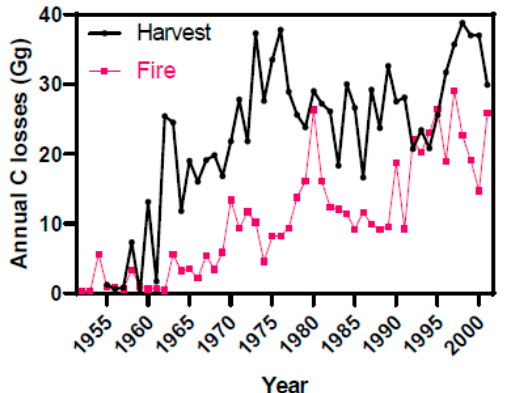
Figure 3. Annual carbon losses from the harvest removal (wood and bark) between 1955 and 2001 (thick dark line with circles) and from prescribed fires and wildfires between 1952 and 2001(thin light line with squares) at the Savannah River Site.